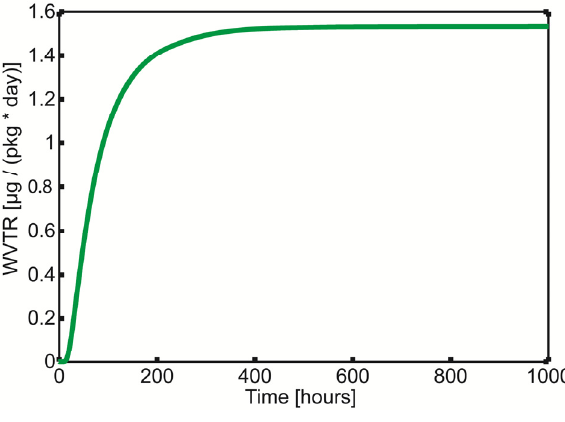
Figure 5. Simulation of water diffusion through thermal polymer welds for 80% RH and 23